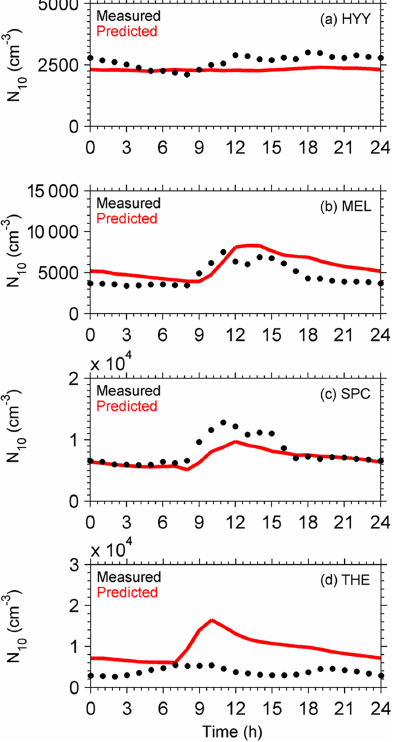
Figure 7. Predicted (red bars) vs. observed (black symbols) con- densation sink at the 16 measurement stations during 5 June– 8 July